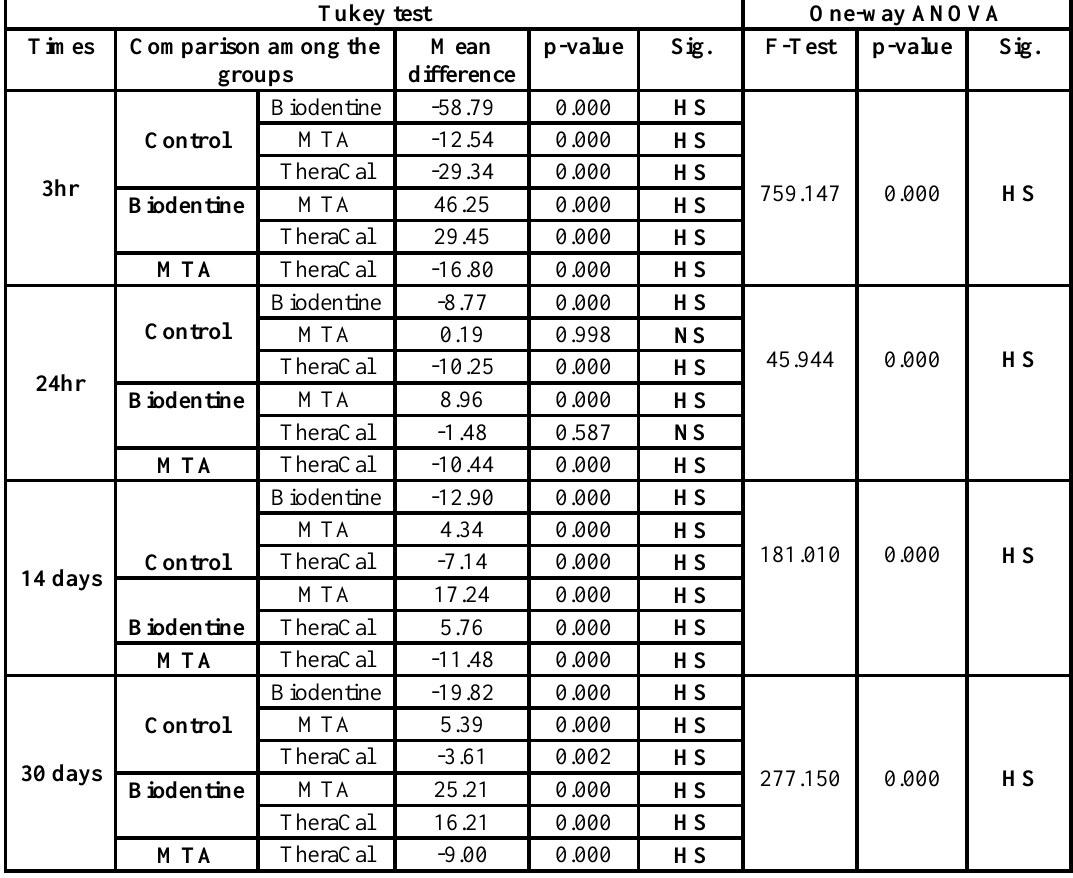
Table (4): Tukey test and one-way ANOVA for comparison among the tested materials in calcium ions released (in ppm) at each immersion time.